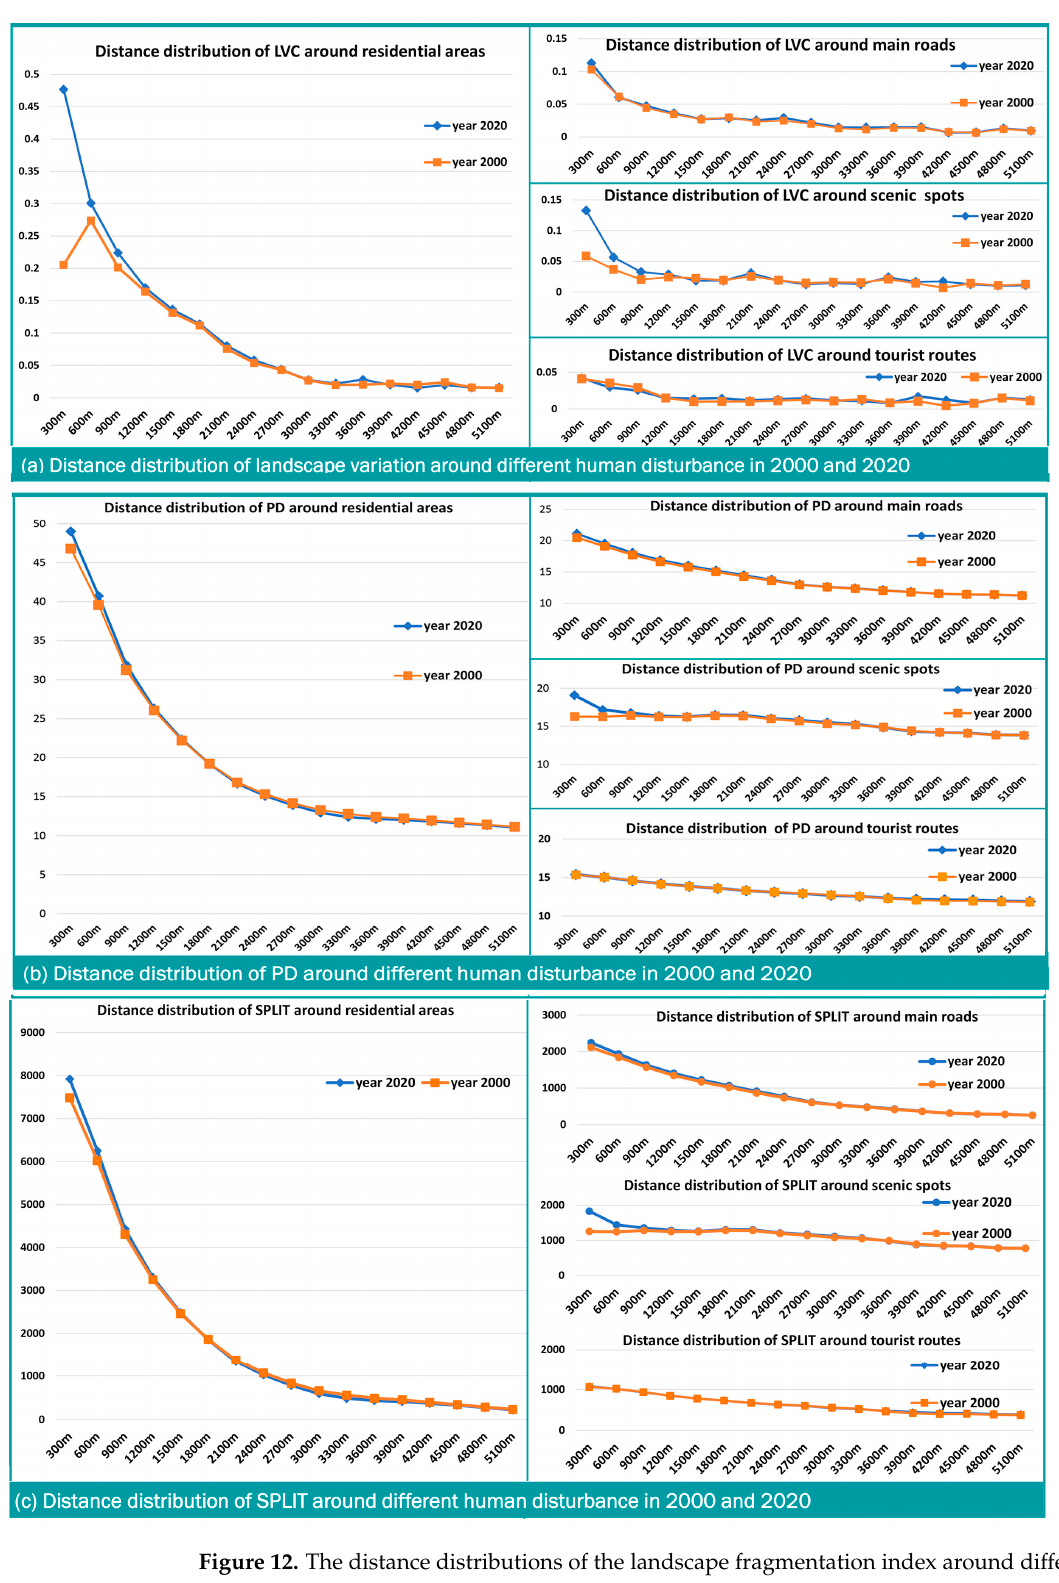
Figure 12. The distance distributions of the landscape fragmentation index around different human disturbances in 2000 and 2020. ( a ) Distance distributions of the LVC around different human disturbances in 2000 and 2020; ( b ) Distance distributions of the PD around different human disturbances in 2000 and 2020; ( c ) Distance distributions of the SPLIT around different human disturbances in 2000 and 2020.